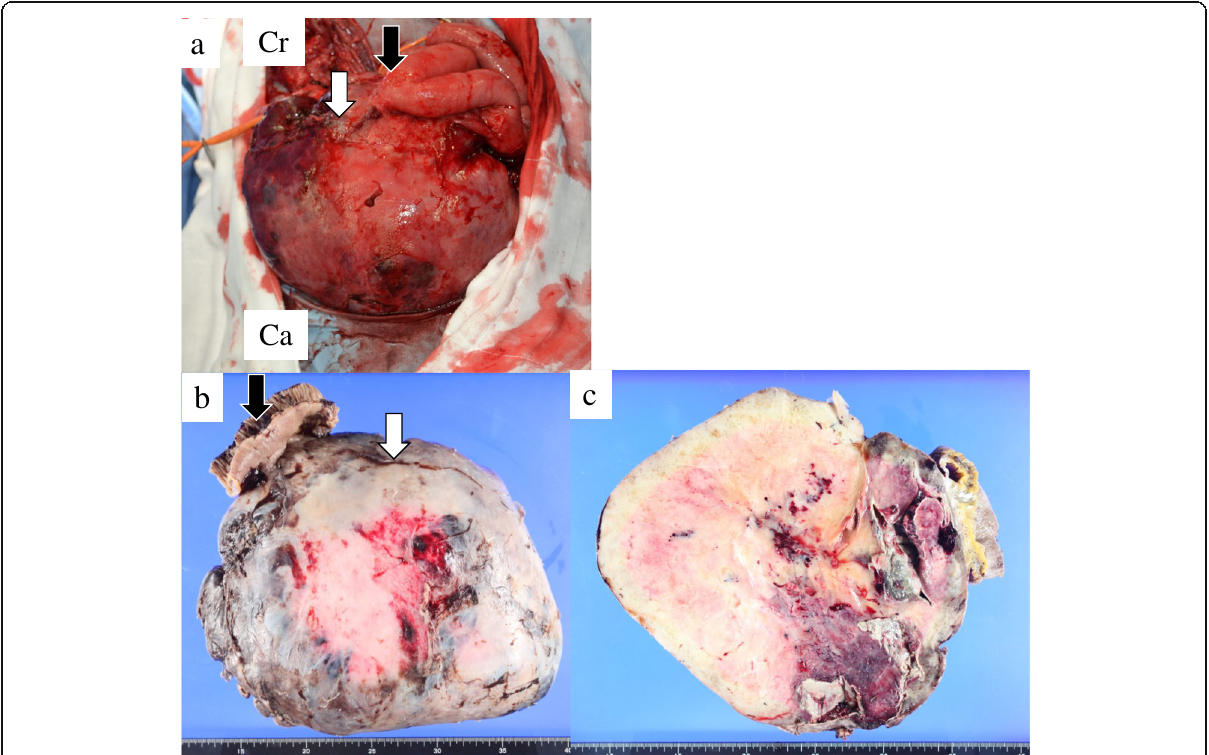
Fig. 3 Intraoperative findings of the first surgery and a resected specimen. a The intra-abdominal mass (white arrow) invaded the small intestine (black arrow) (Cr, cranial; Ca, caudal). b The tumor had a smooth surface. c The cut plane looked white and solid inside